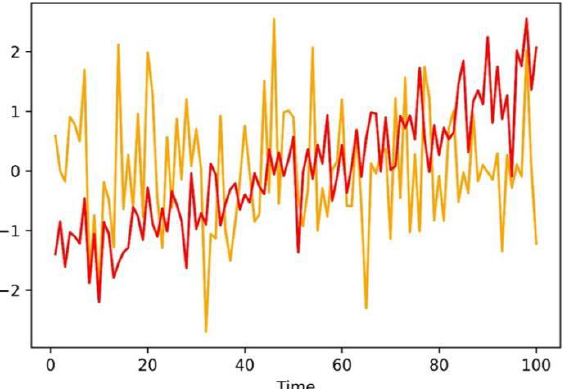
Figure 2. The comparison of one variable of 𝑤̂ 𝑖 for normal data (yellow) and fault data (red).